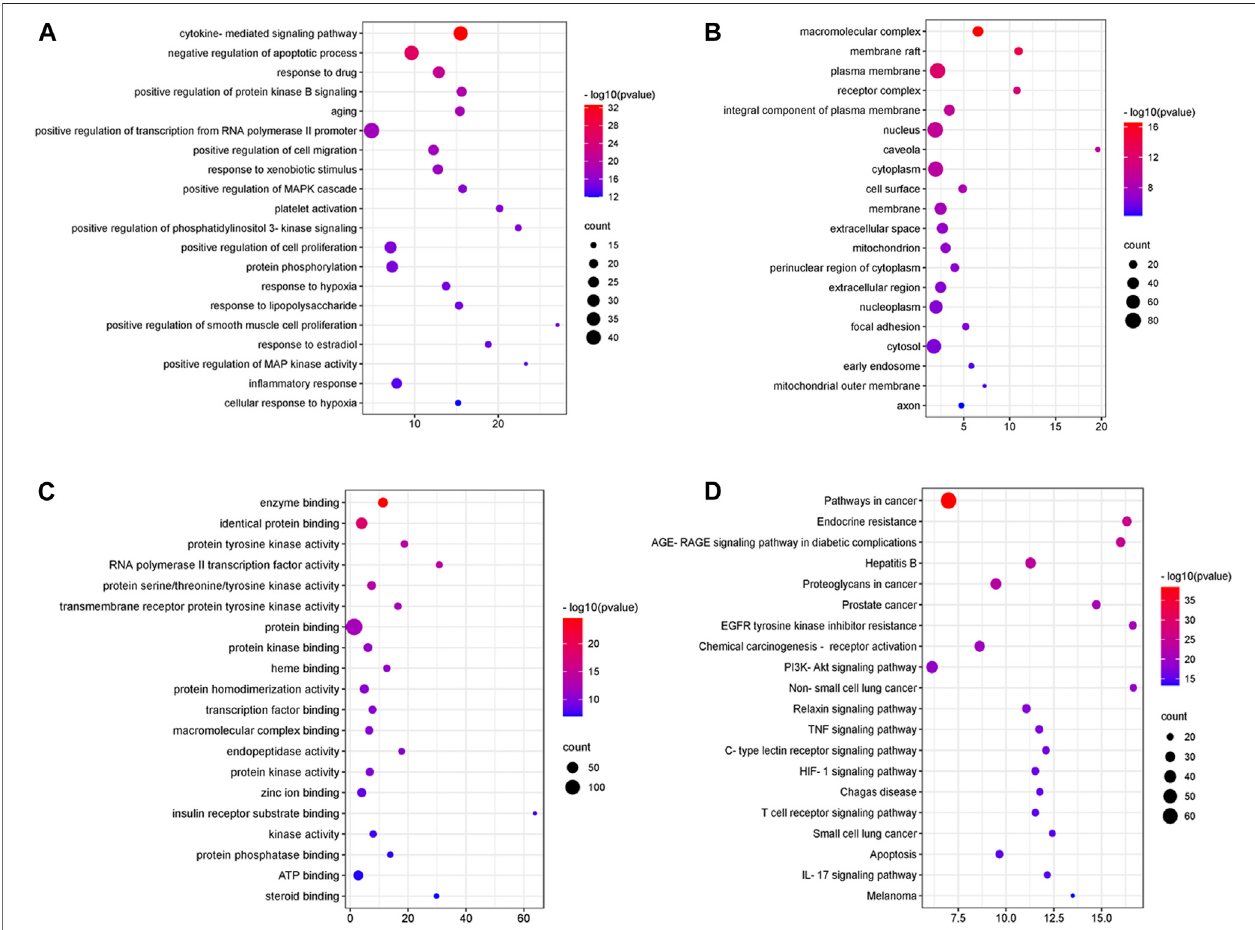
FIGURE 3 | GO enrichment and KEGG pathway analysis of DSY targets. (A) “ biological process ” (BP) categories, (B) “ cellular components ” (CC) categories, (C) “ molecular function ” (MF) categories and (D) KEGG pathways.